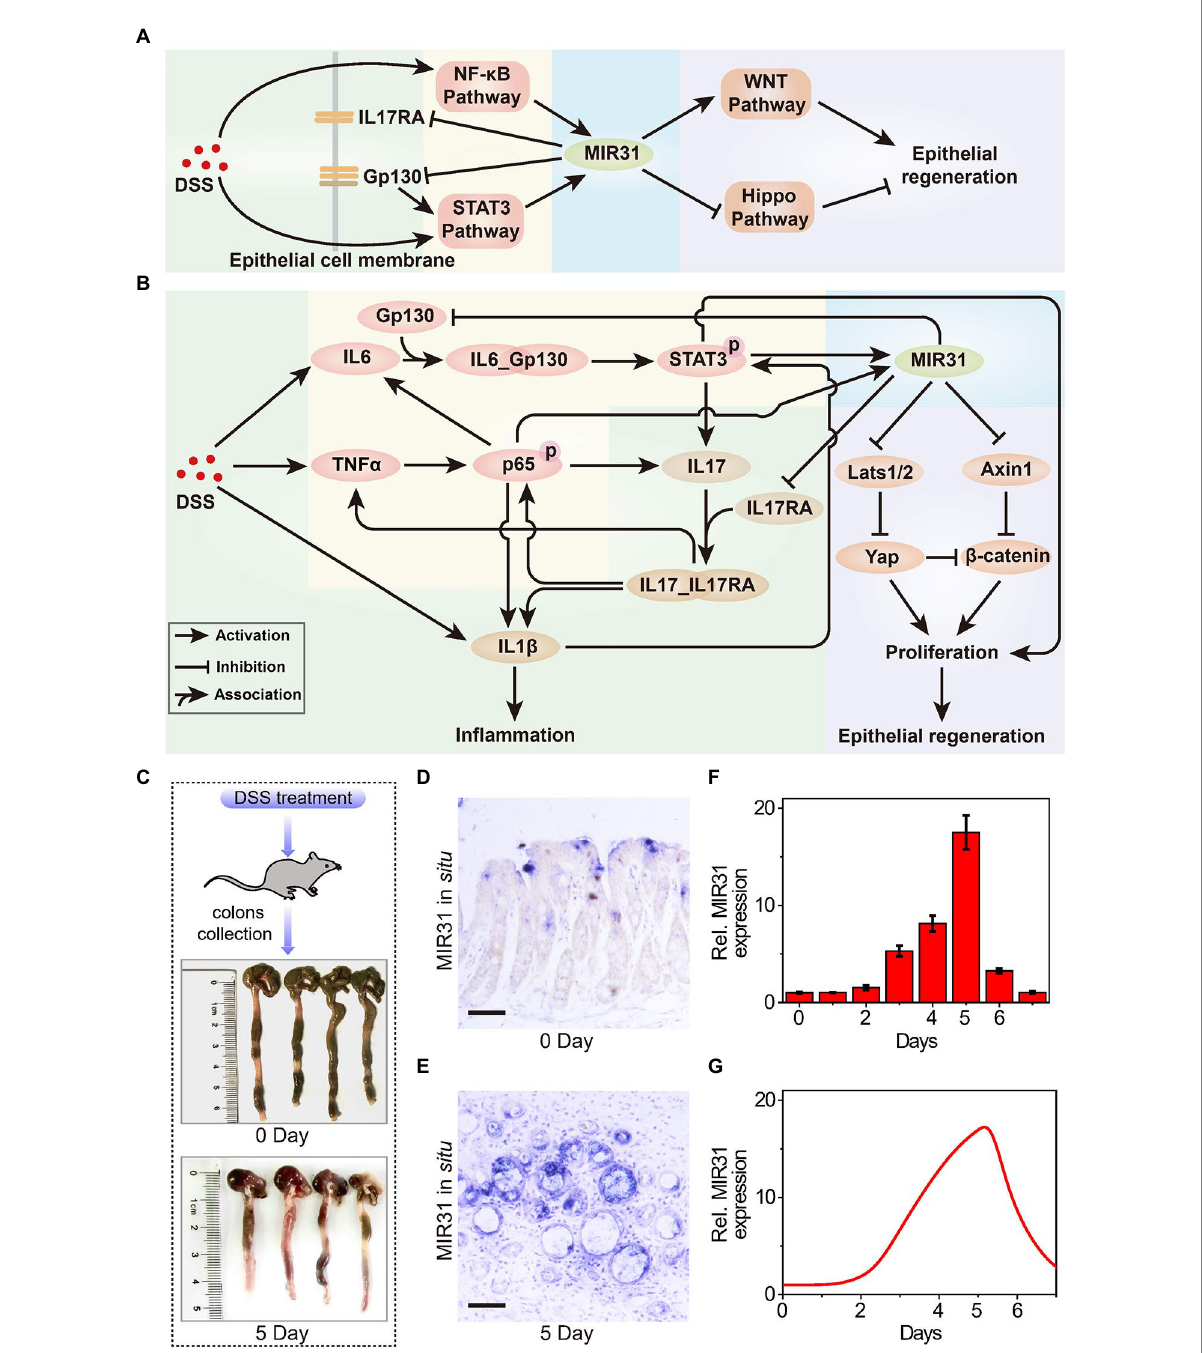
FIGURE 1 The role of MIR31 in DSS-induced colitis signaling network. (A) Simplified signal transduction network of DSS-induced colitis to show the main interactions between MIR31 and four pathways of NF- κ B, STAT3, WNT and Hippo signals. (B) Detailed signal transduction network. The network is composed of four modules, which are highlighted by different backgrounds. The green background is for the module of DSS-induced inflammatory cytokine production, the yellow for the module of MIR31 induction, the blue for the module of MIR31-inhibited inflammatory cytokine production, and the purple for the module of MIR31-promoted epithelial regeneration. (C) WT mice used in our experiments and colonic tissues collected from WT mice at 0 day and 5 day of DSS treatment. (D) In situ hybridization for MIR31 in normal colons without DSS treatment. (E) In situ hybridization for MIR31 in colons from mice treated with DSS for 5 days. (F) qRT–PCR analysis showing MIR31 expression levels in the colonic epithelium from DSS-treated mice at the indicated time points. n = 4 at each time point. (G) Simulation results of the MIR31 expression level over time in DSS-induced WT